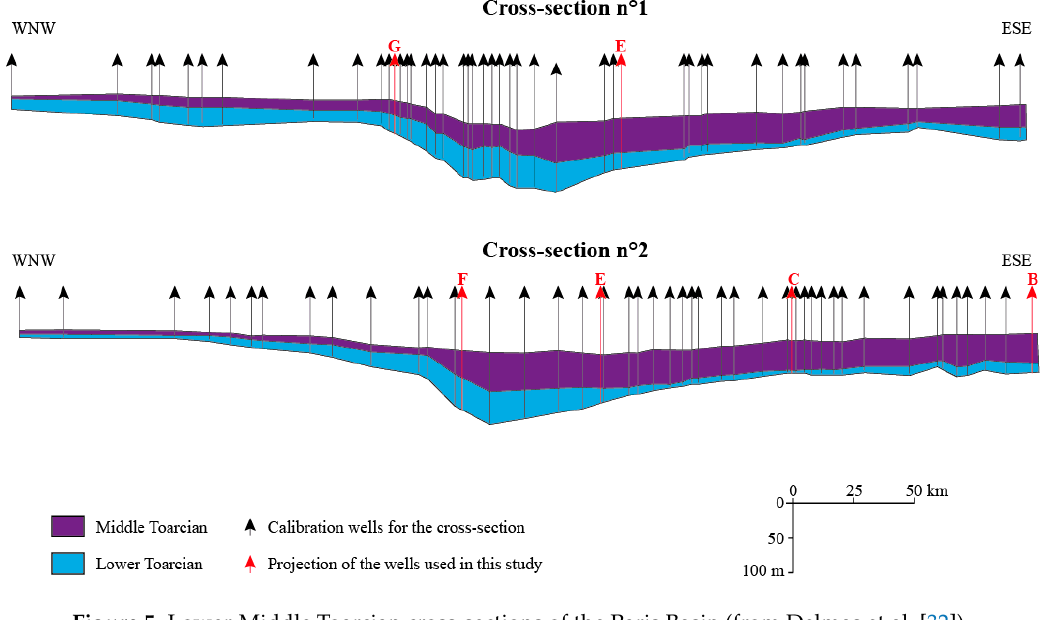
Figure 5. Lower-Middle Toarcian cross-sections of the Paris Basin (from Delmas et al. [32]).